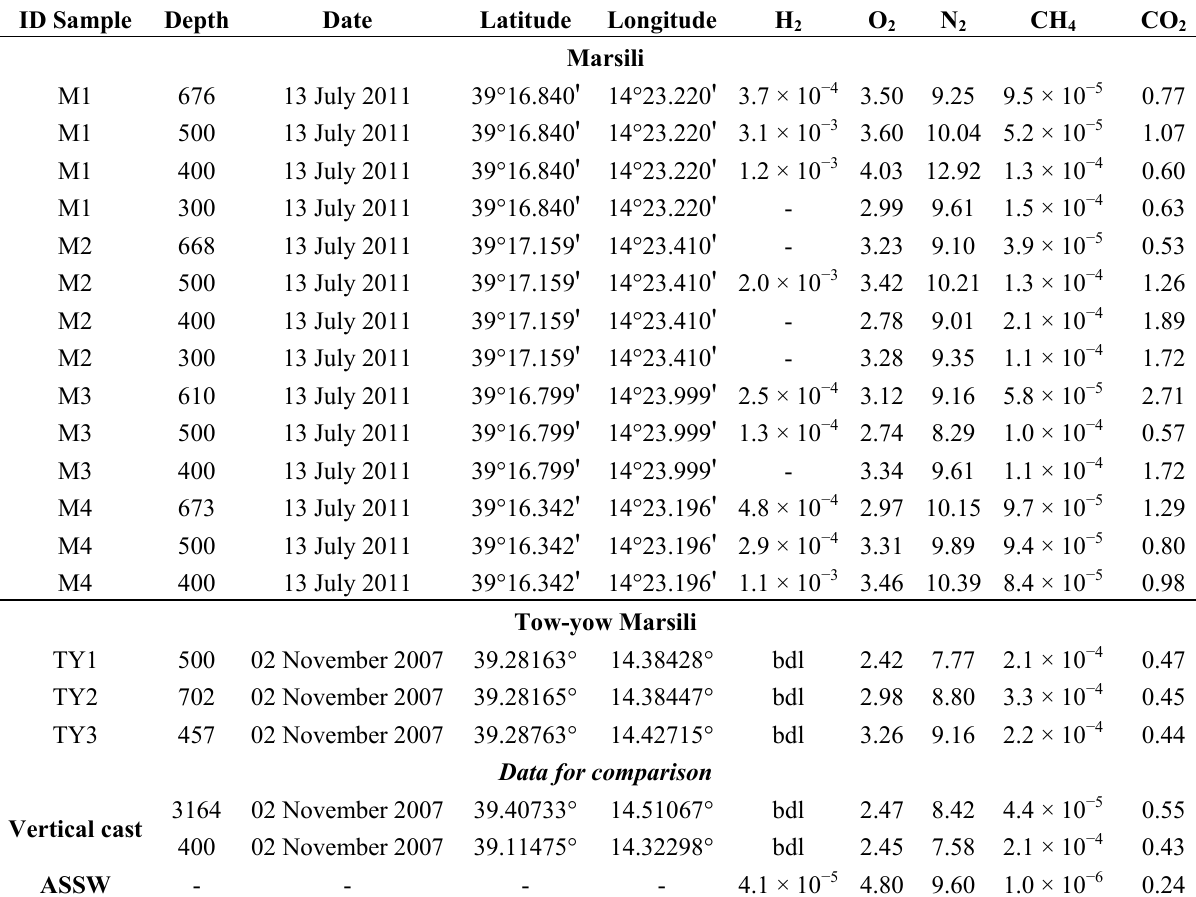
Table 1. Analytical results of the dissolved gas phase in samples collected during two different cruises (2007 and 2011). Hydrothermal-derived gases are released besides components from the atmosphere. Analytical results in cm 3 STP/L Depth in meters. Bdl = below detection limits. Data of ASSW (Air Saturated Sea Water) and from the bottom sample of a vertical cast carried out over the Tyrrhenian Abyssal plain are reported for comparison. Coordinates are reported as they were collected during the